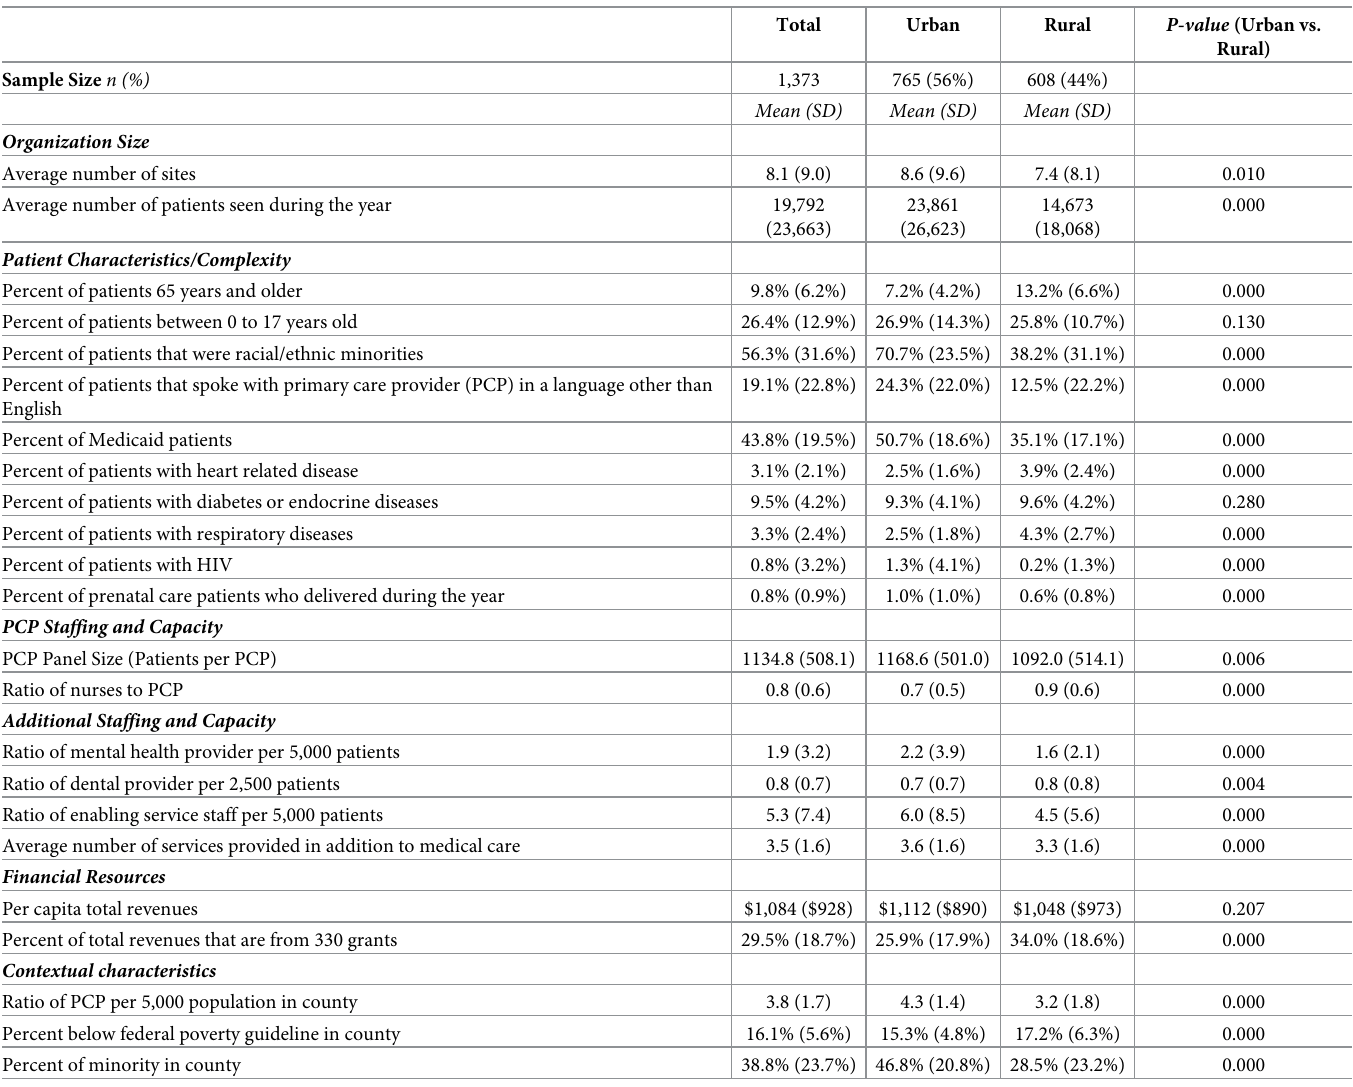
Table 1. Contextual